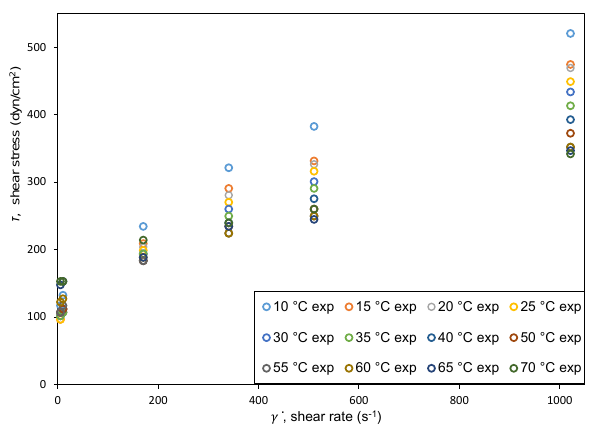
Figure 4: Shear stress vs. shear rate (FANN viscometer readings) in the temperature range of 10-70 ∘ C.